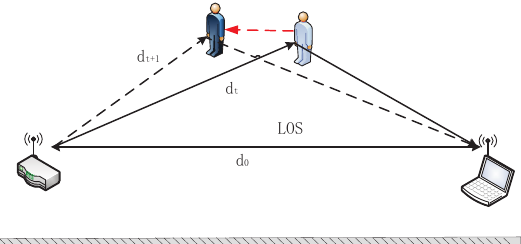
Figure 1. Single-bound reflection